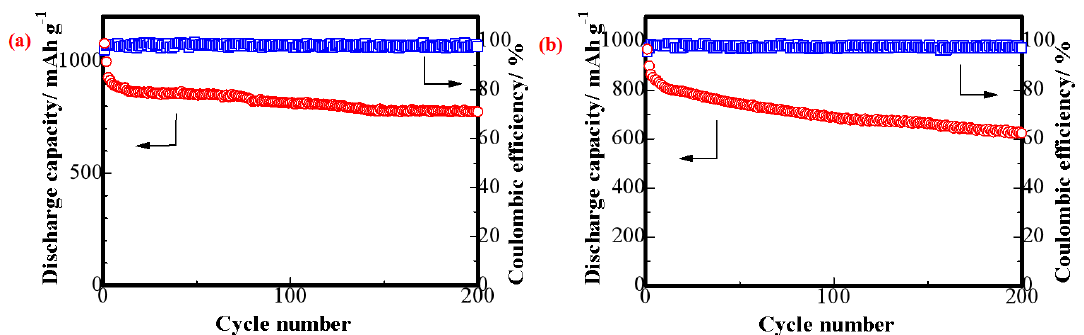
Figure 10. Cycling performances (red) and coulombic efficiencies (blue) of the lithium–sulfur batteries with the ( a ) S/CeO 2 /RGO and ( b ) S/RGO cathodes under 0.1 C.